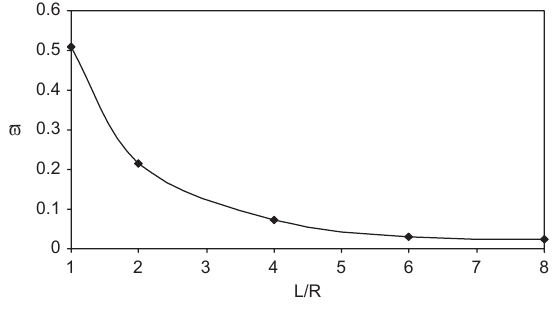
Figure 4 Effect of L/R ratio on the optimum fundamental frequencies.